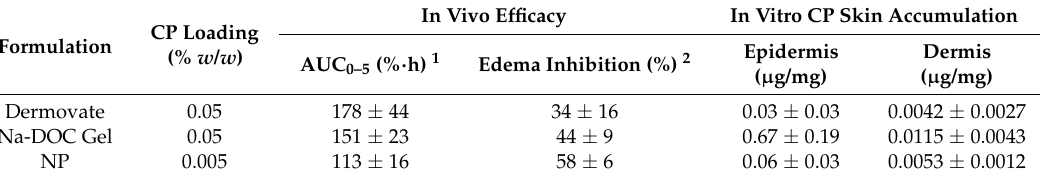
Table 1. Comparison between in vivo anti-inflammatory efficacy data (AUC and % of inhibition) obtained after formulations application and in vitro CP accumulation ( µ g/mg) after application in isolated pig skin